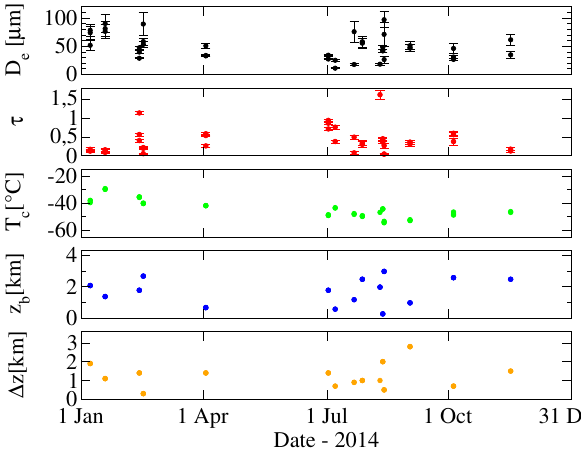
Figure 11. Time evolution of the retrieved cloud parameters: the generalised effective diameter D e , optical depth τ , the cloud tem- perature T c . The cloud bottom height z b and the thickness (cid:49)z pro- vided by the lidar are also shown.